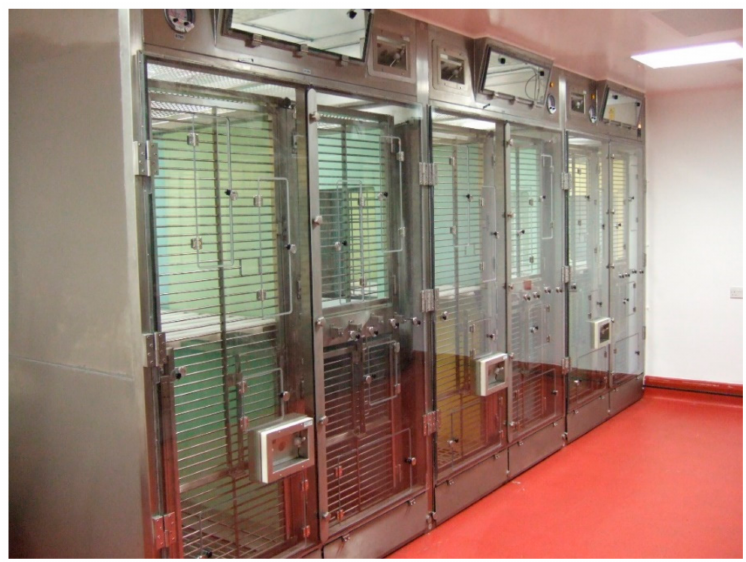
Figure 1. Containment system for group housing of macaques at Public Health England (PHE). Three cages are shown, each consisting of four units. (Image: Mike Dennis,